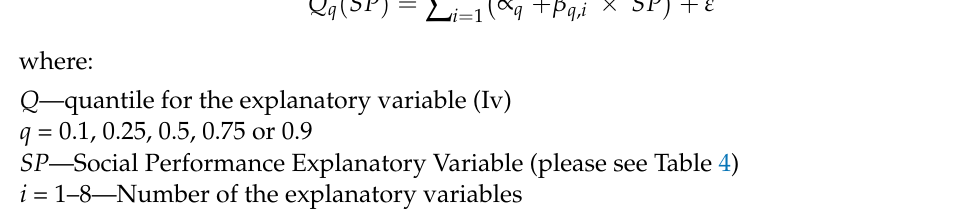
Table 4. Analysis results of least square regression model and quantile regression model for social